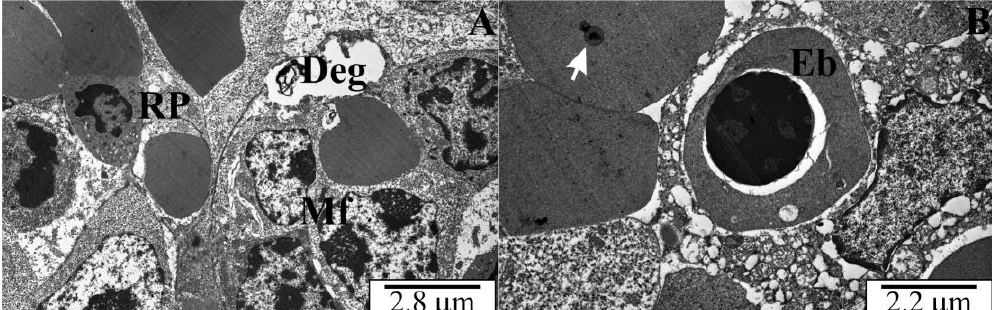
Figure 12. ( A , B ) Ultrathin sections across spleens of intrauterine rats infected with B. microti. Deg—degenerating zones, Eb—erythroblast, Mf—macrophage, RP—red pulp, white arrows—B. microti merozoites.